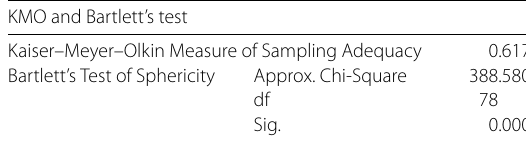
Table 5 KMO and Bartlett’s analysis